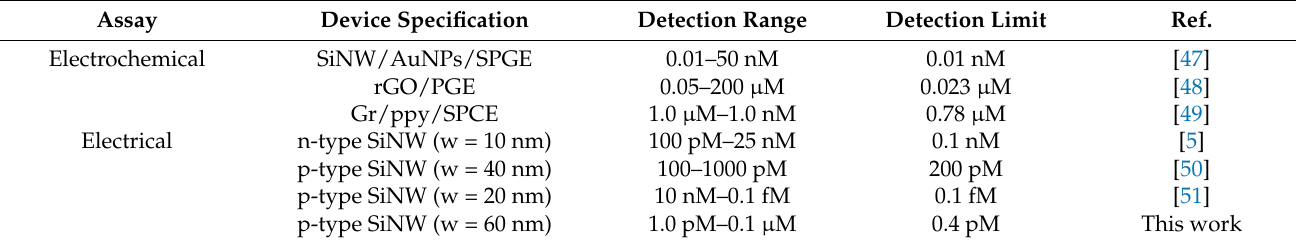
Table 2. Analytical performance of DNA